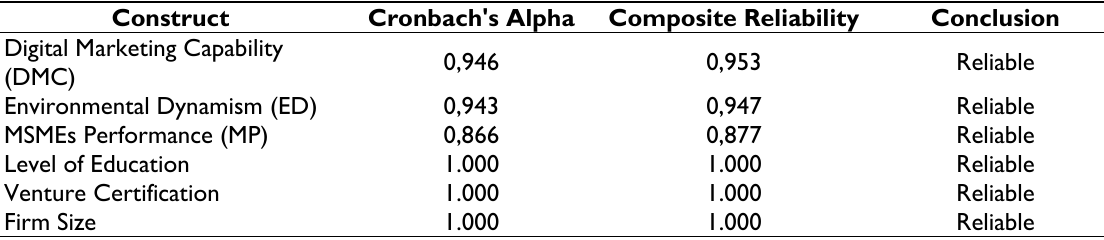
Table 5. Cronbach's Alpha and Composite Reliability